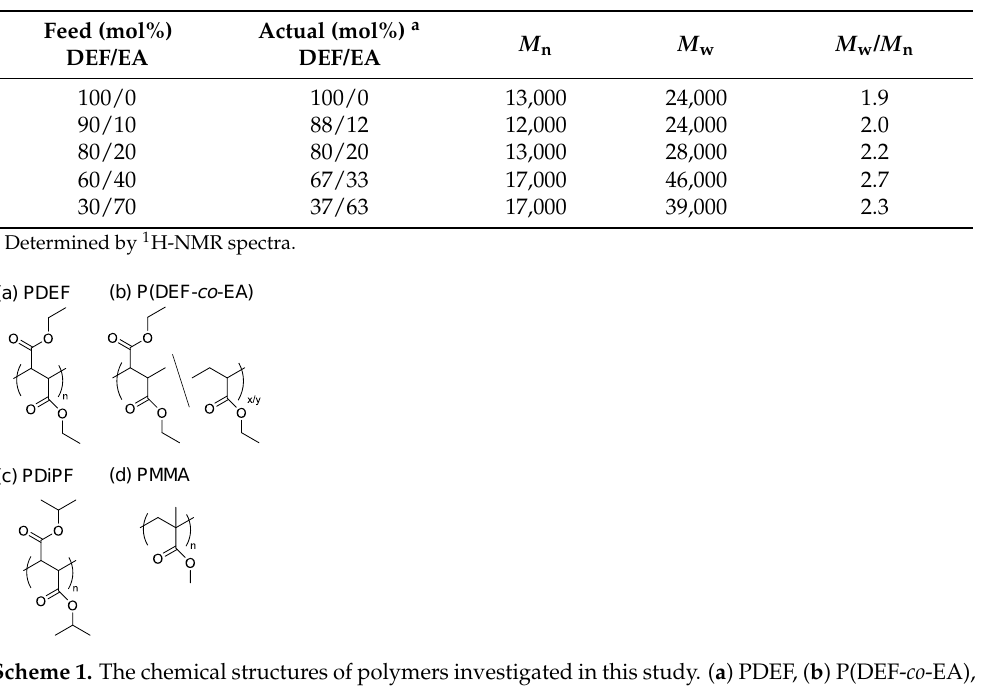
Table 1. List of polymers synthesized in this study.